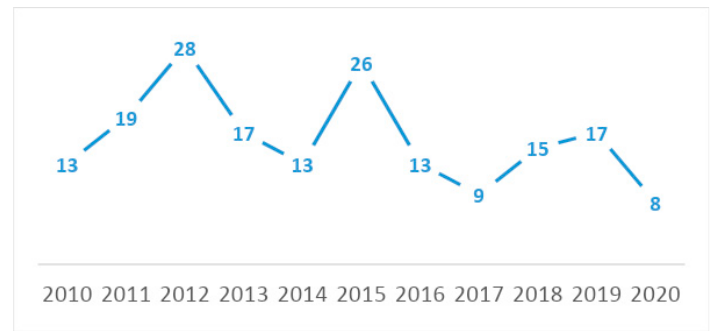
Figure 1. Number of included studies by year of publication.